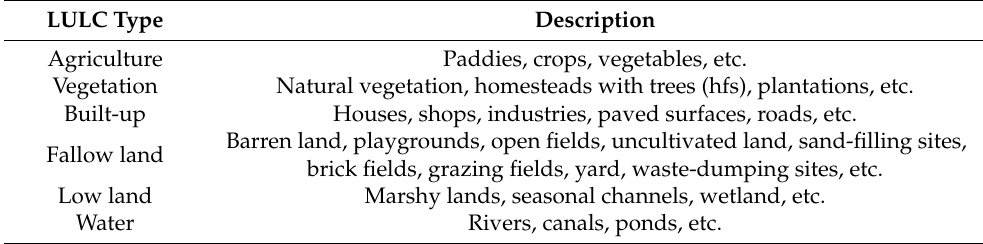
Table 2. LULC classification